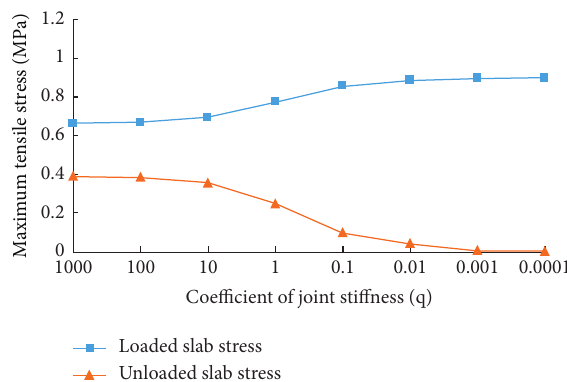
Figure 7: Relationship between coefficient of joint stiffness q and maximum tensile stress for loaded slab and unloaded slab in intact pavement.